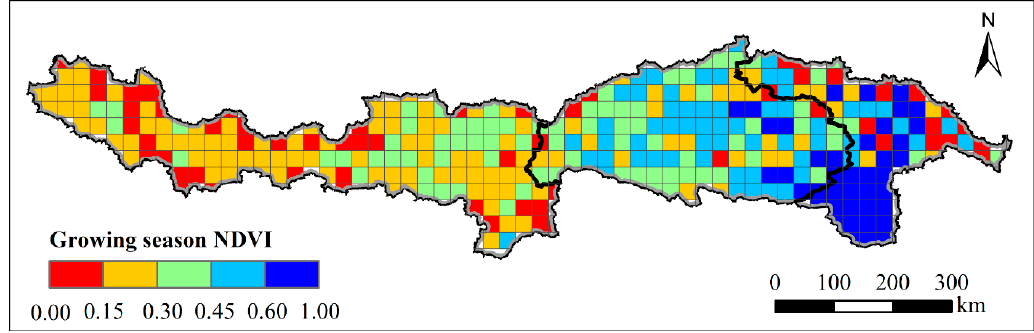
Figure 3. The spatial distribution of the multi-year average value of the growing season NDVI since 2000 in the YZR basin.